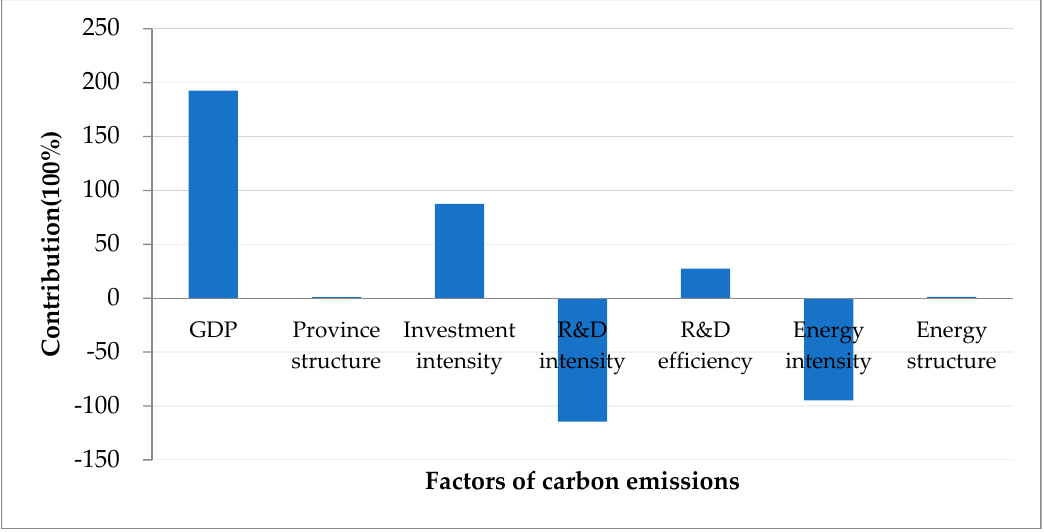
Figure 5 . Accumulated contributions of different factors of carbon emissions on energy consumption of China in 2014.